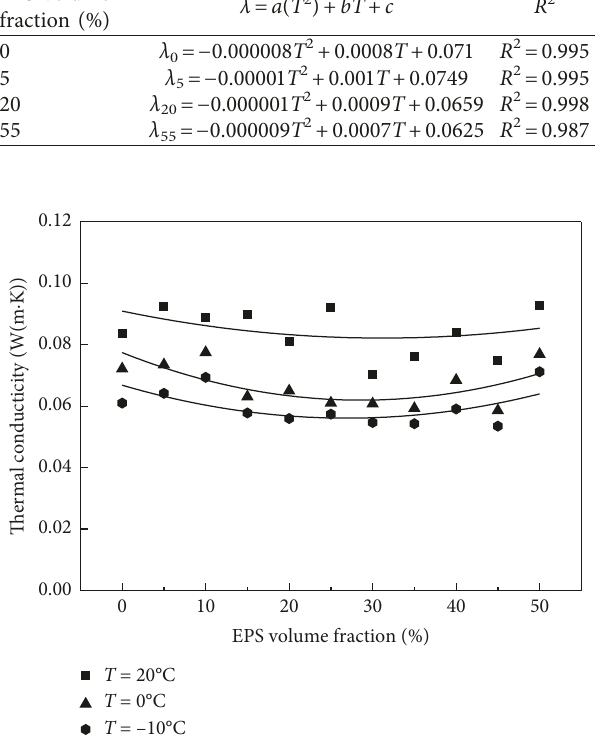
Figure 6: Thermal conductivity of different temperature FC with various EPS volume